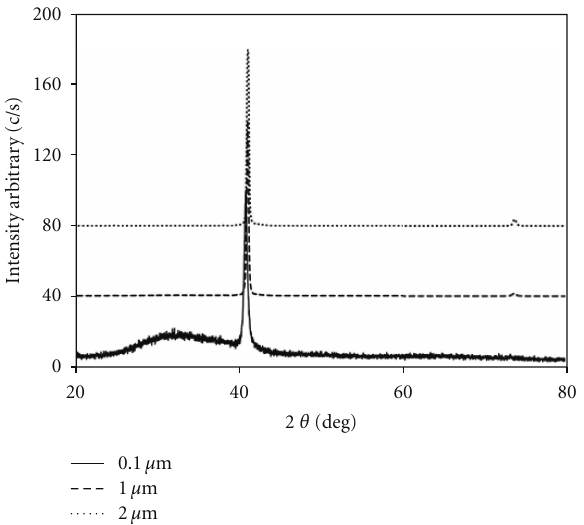
Figure 1: θ/ 2 θ XRD scans of ZnO:Al films with di ff erent thick- nesses, grown from ceramic targets.